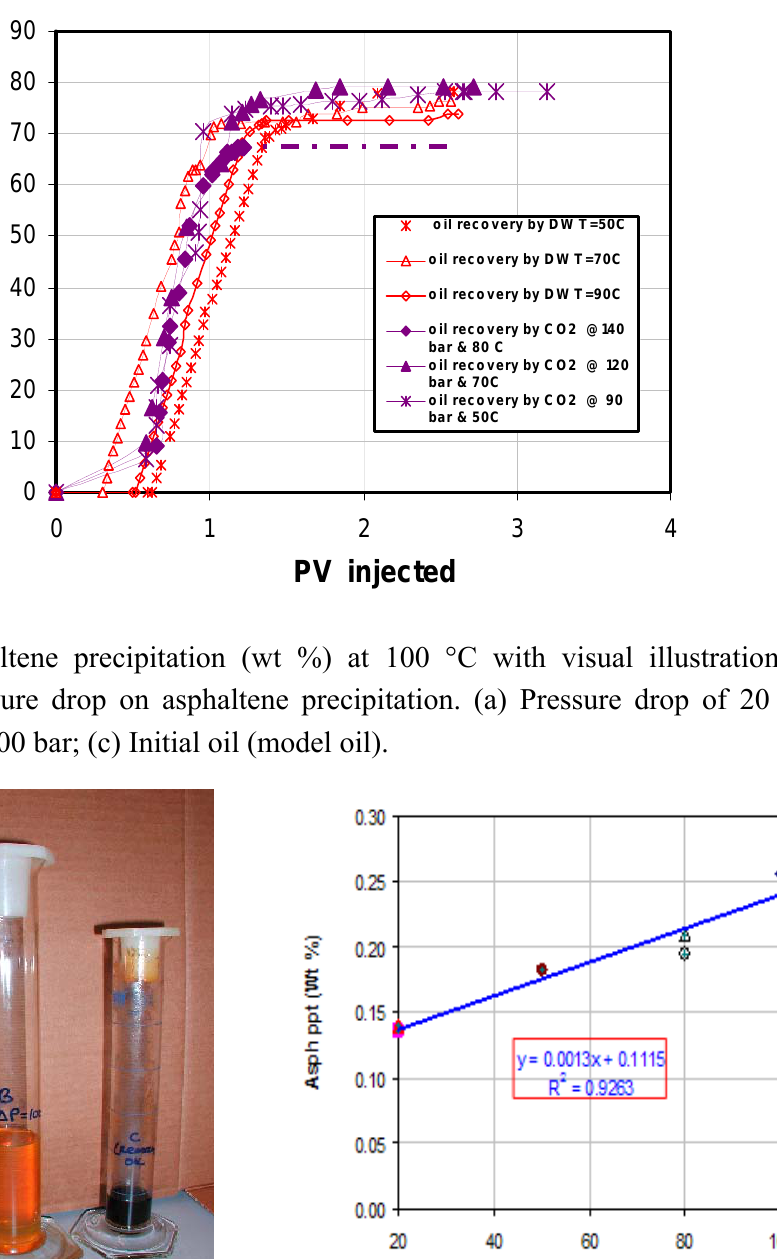
flooding for model oil 2 2